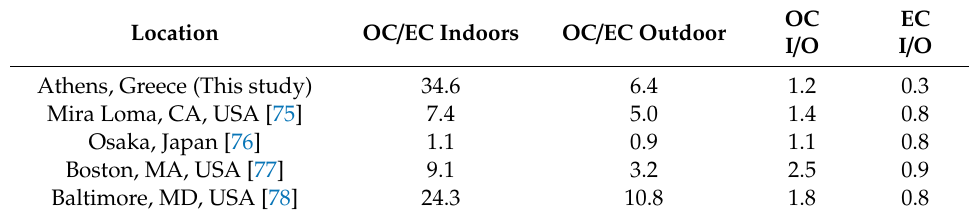
Table 4. Average ratios of organic carbon (OC) and elemental carbon (EC) concentrations in di ff erent sampling sites. Location OC / EC Indoors OC / EC Outdoor